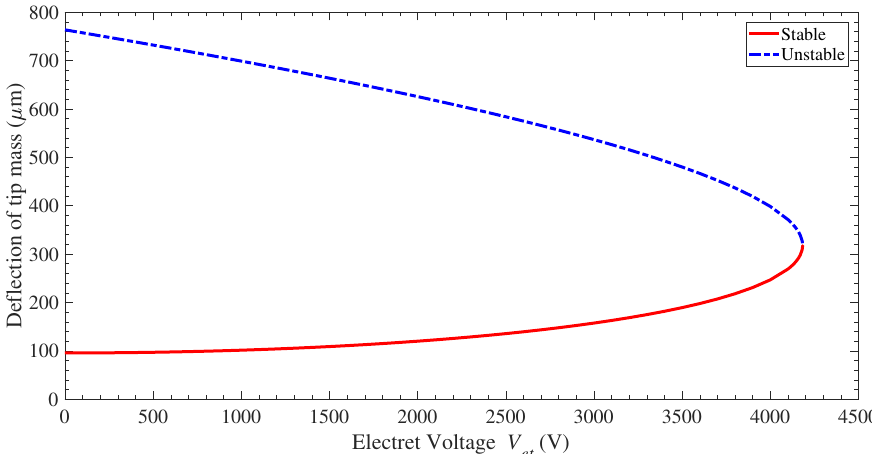
Figure 4. Variation of the static deflection z st as a function of the electret voltage.